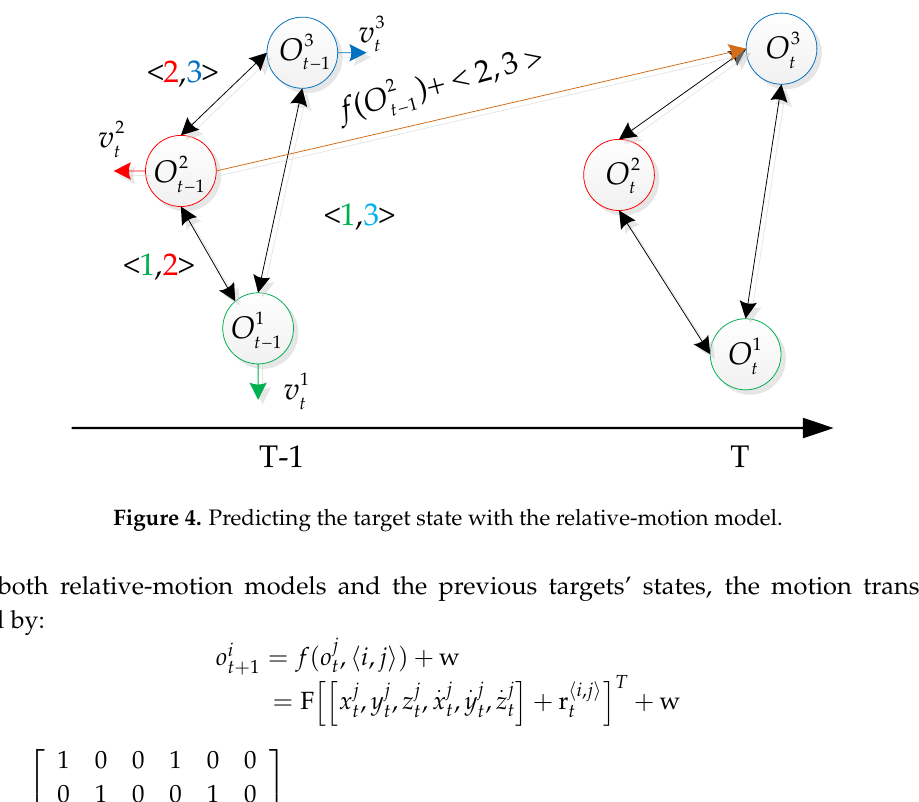
Figure 3. Observation likelihood model.